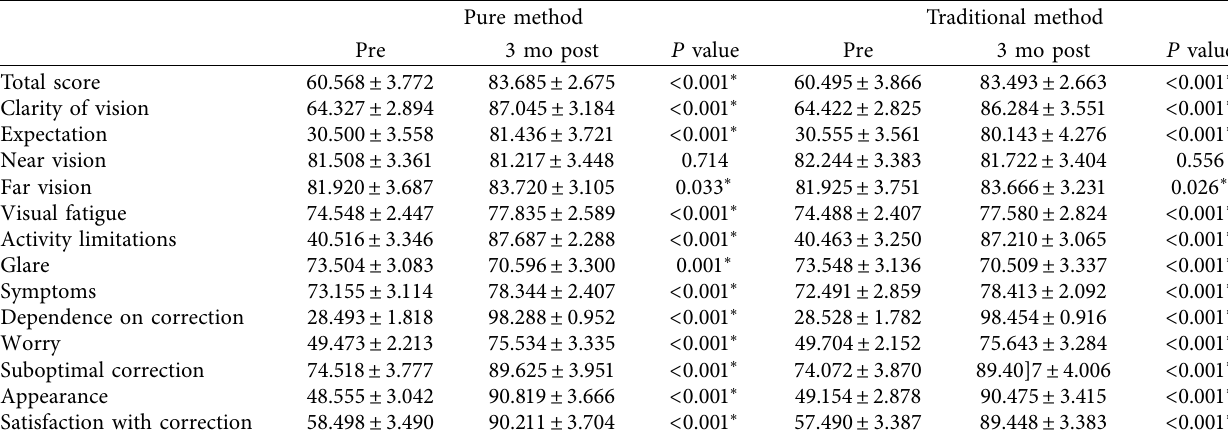
Table 6: NEI-RQL-42 scores before and 3 months after surgery in the pure ICL implantation and traditional ICL implantation groups. Pure method